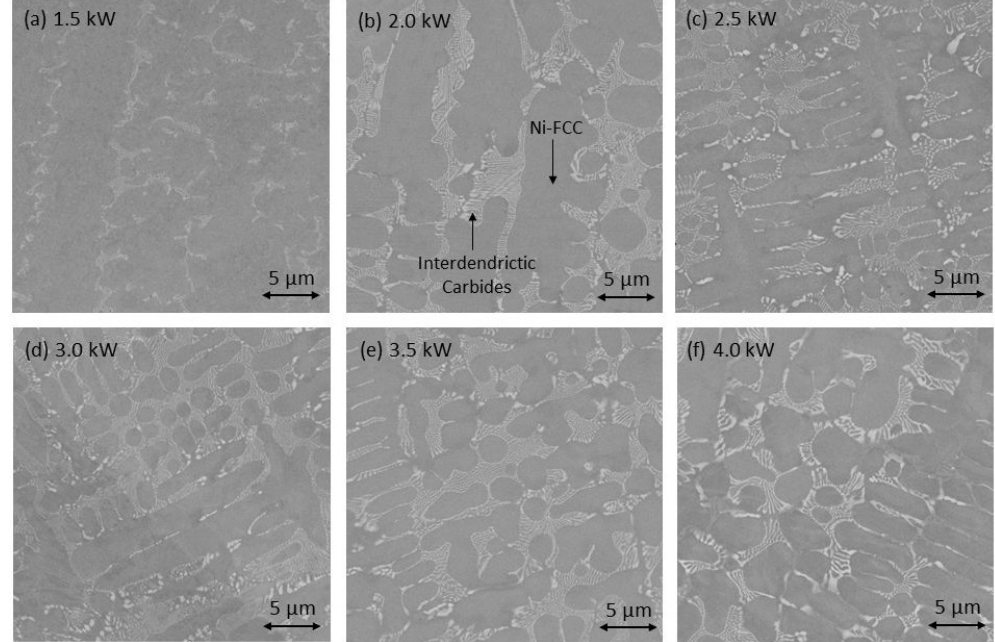
Figure 8. The microstructure of coatings deposited on GGG 40 versus laser power.